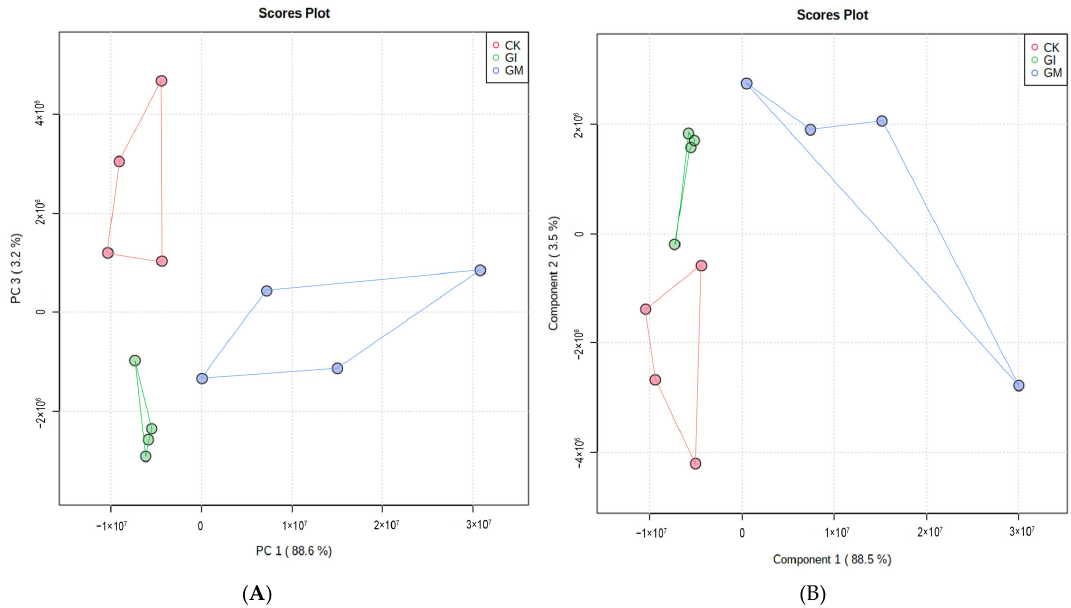
Figure 3. The principal components analysis (PCA, ( A )) and supervised partial least squared discriminant analysis (PLS–DA, ( B )) of metabolite profiles in fat body of gypsy moth larvae.